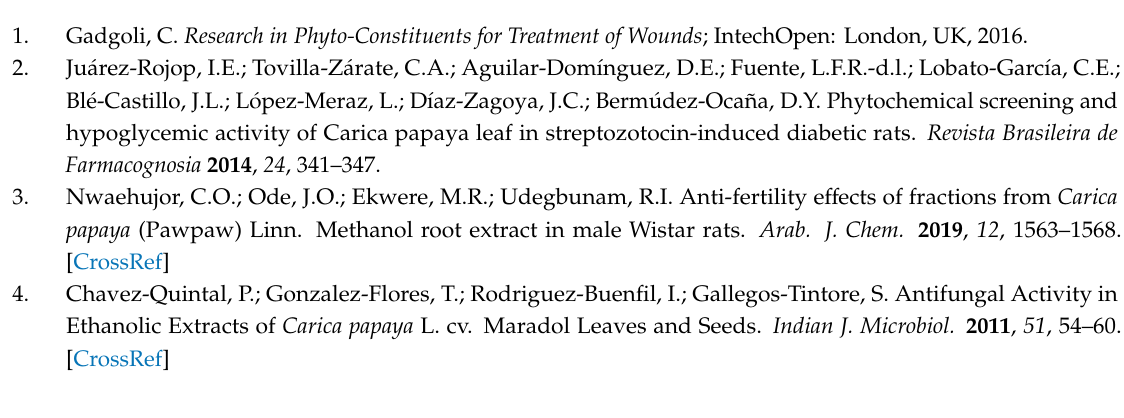
Figure S1: Compounds profiles of C. papaya obtained from reflux